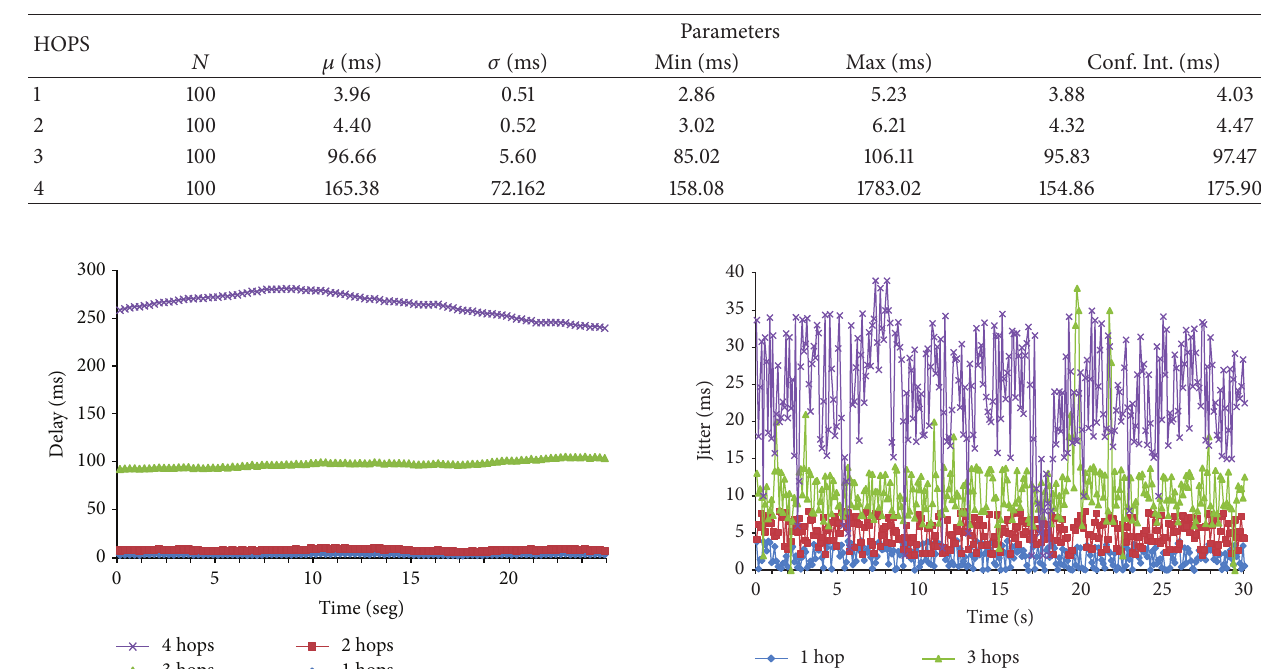
Table 4: Statistical values of the delay as a function of the diameter.